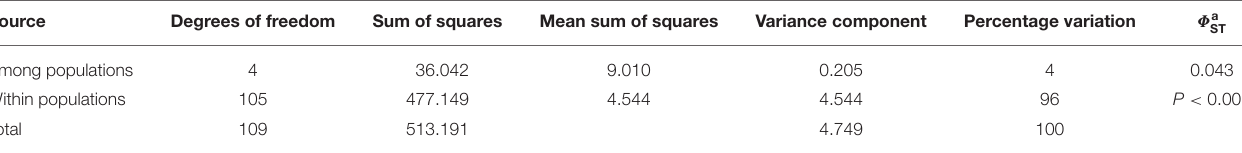
Source Degrees of freedom Sum of squares Mean sum of squares Variance component Percentage variation Φ a ST Among populations 4 36.042 9.010 0.205 4 0.043 Within populations 105 477.149 4.544 4.544 P < 0.001 Total 109 513.191 a Population